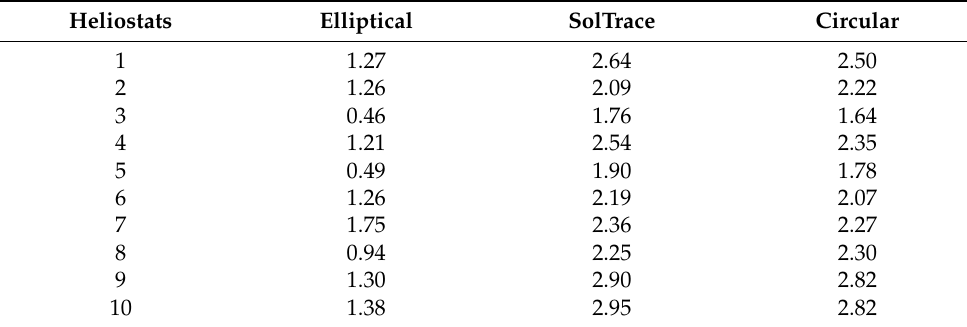
Table 5. The absolute average difference in intercept factor of ten